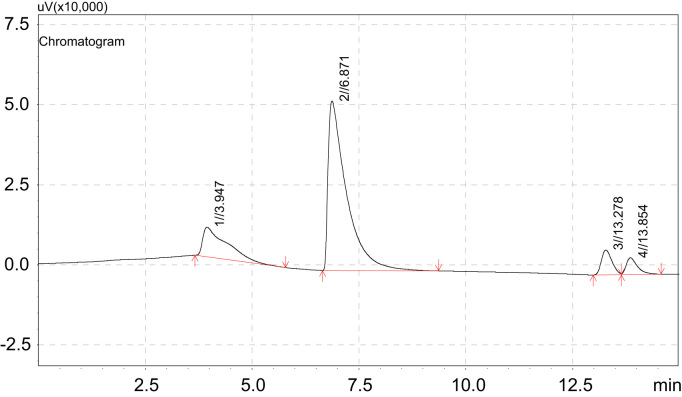
Sample standard.